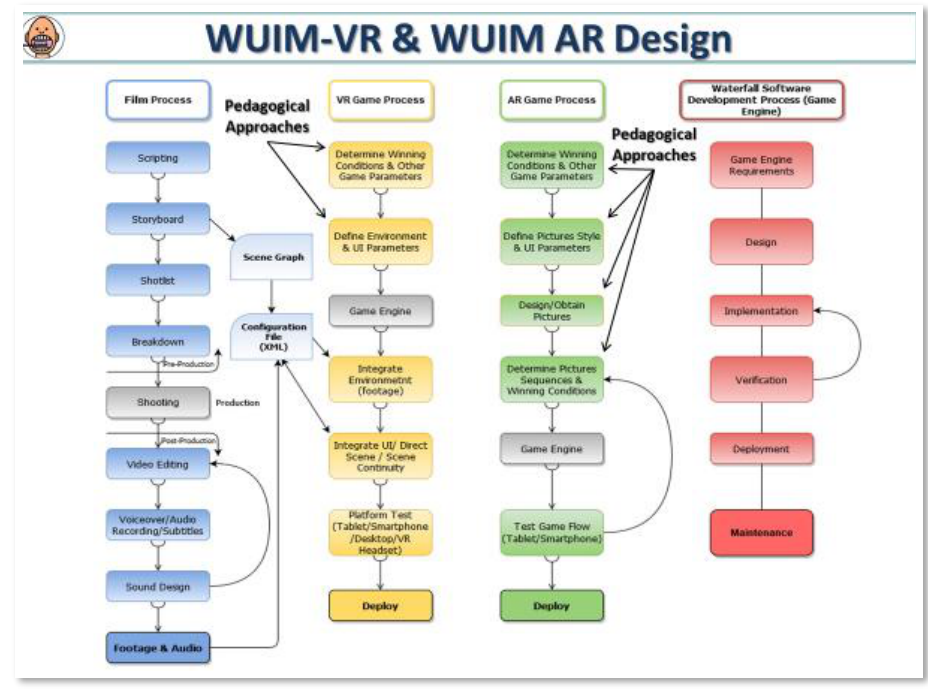
Figure 21. Post-production phase: color subtitles/background. Subtitling while the pedagogical